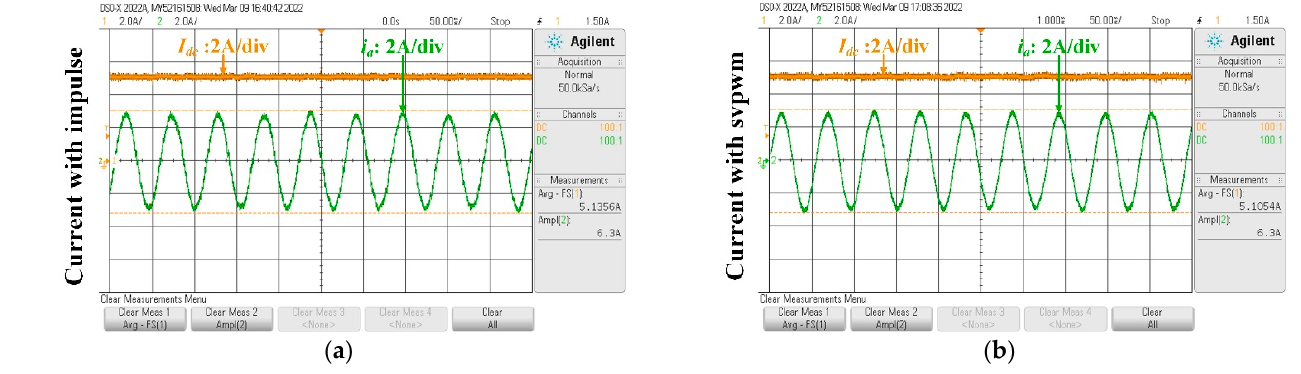
Figure 7. The DC-link current ratio: ( a ) impulse current PWM technique; ( b ) SVPWM.